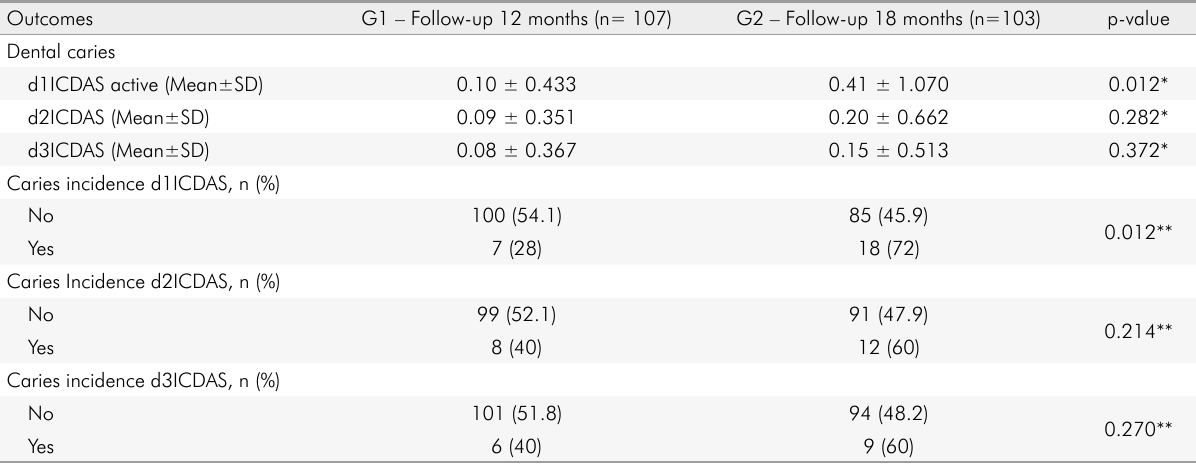
Table 3. Comparison between the groups at the end of the study.